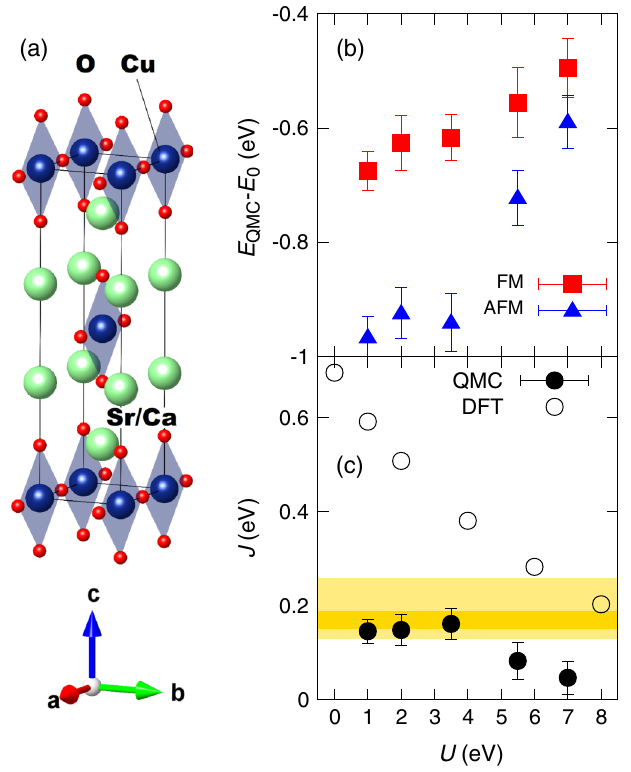
FIG. 1. (a) The conventional “ 1 × 1 × 1 ” unit cell of Ca 2 CuO 3 and Sr 2 CuO 3 . For calculations, the unit cell crystallographic parameters reported in Ref. [11] are used. (b) The total energies of the antiferromagnetic and ferromagnetic states of Ca 2 CuO 3 calculated with FP DMC as a function of the trial wave function, characterized by the LDA þ U parameter U , used here as a variational parameter. For convenience of presentation, the FP- DMC energies are shifted by E 0 ¼ 34705 eV. (c) The nearest- neighbor Cu spin superexchange coupling constant J of Ca 2 CuO 3 calculated with WIEN2k (DFT) and FP DMC as a function of U . For comparison, the ranges of experimentally determined J values of Sr 2 CuO 3 are shown in light gold and dark gold bands. The light gold band represents all reported experimental estimates [6], while the dark gold band represents the magnetic suscep- tibility measurements [7,8].